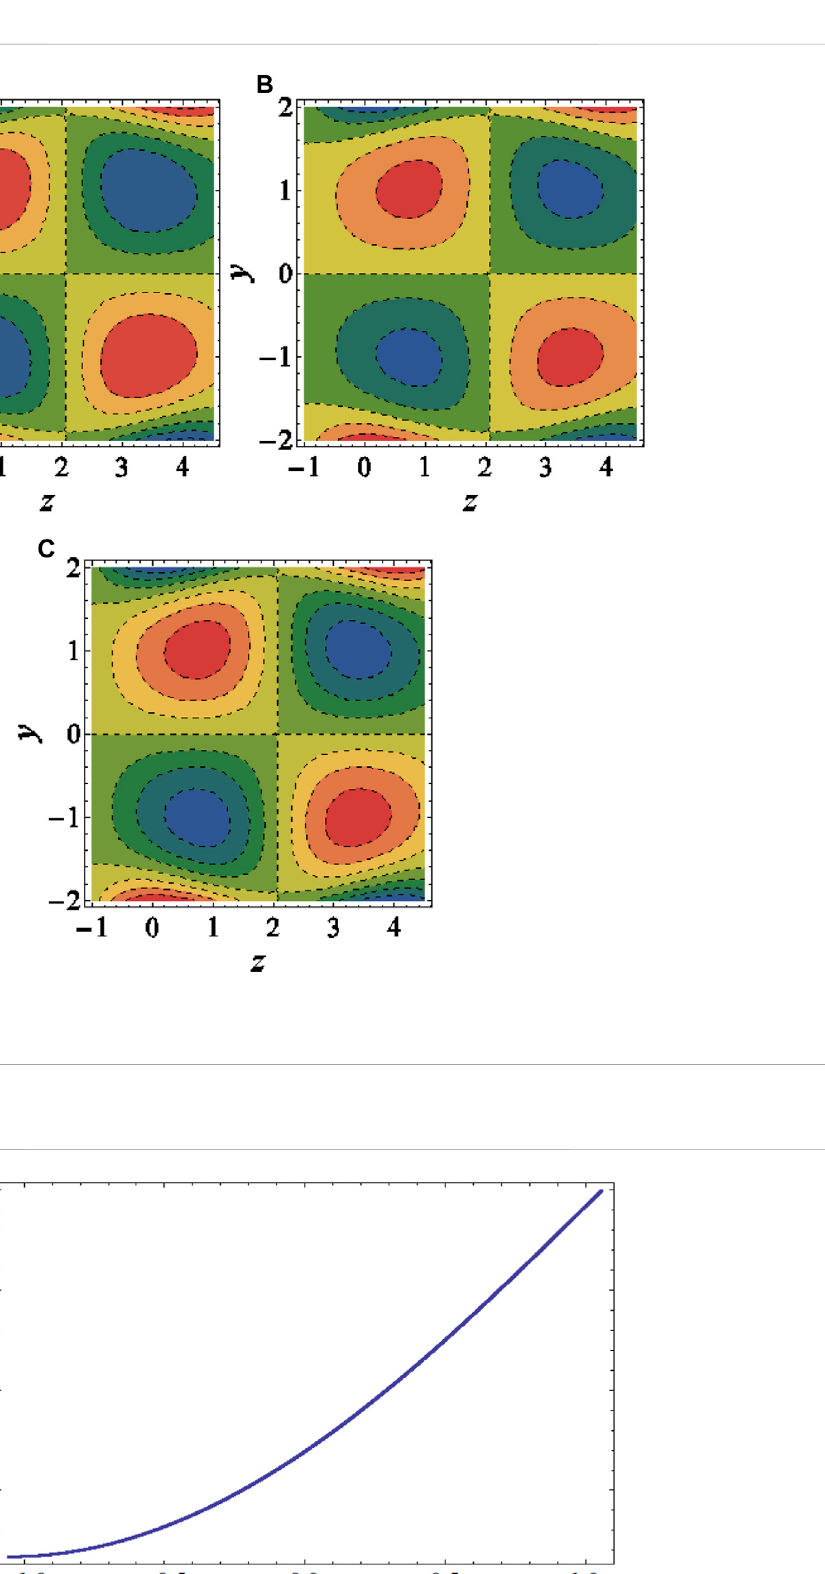
FIGURE 12 Residual error curve for the axial velocity function, w